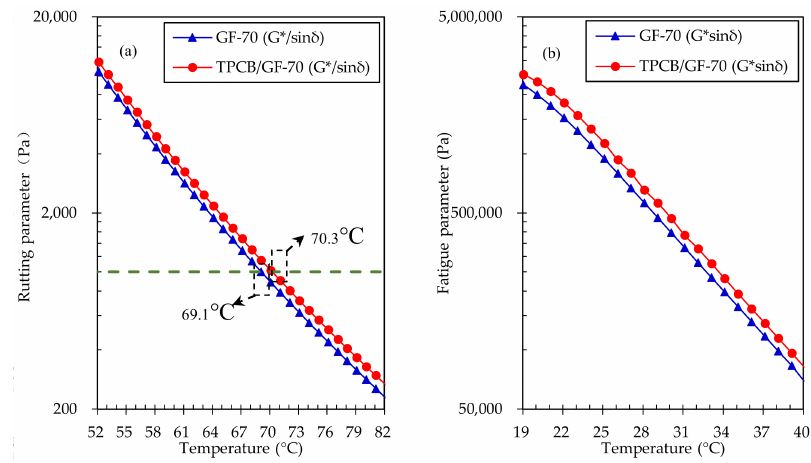
Figure 6. G*/sin δ ( a ) and G*sin δ ( b ) of GF-70 and TPCB/GF-70.